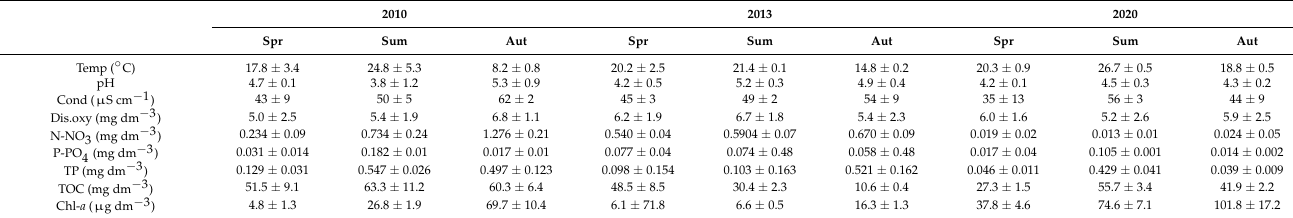
Table 1. Mean values (±SD) of physical and chemical water parameters of peat pool habitat.